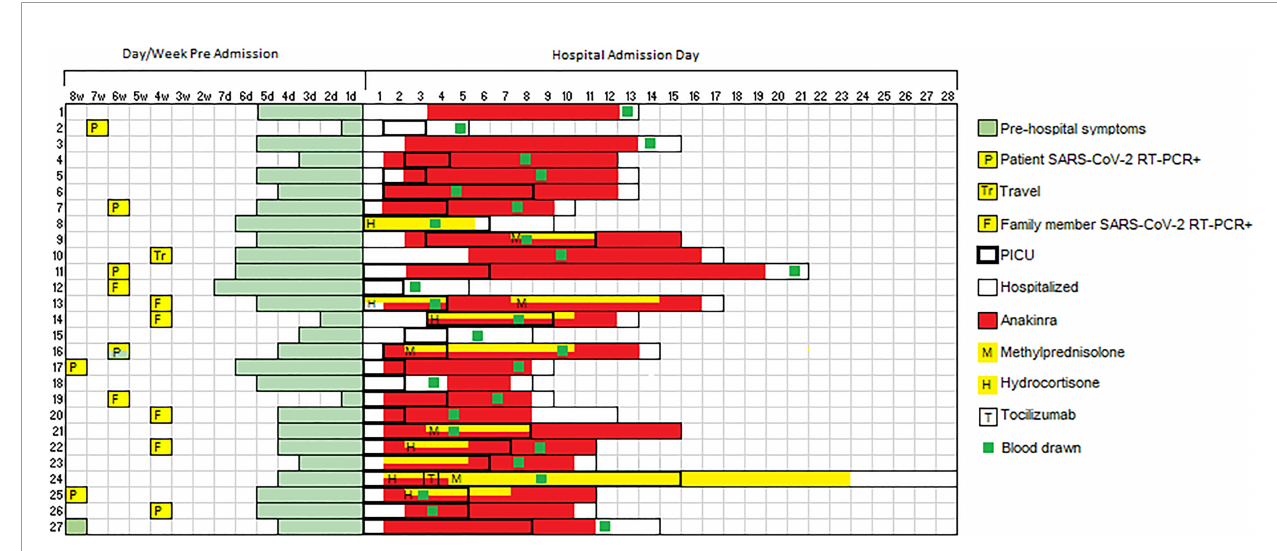
FIGURE 1 | SARS-CoV-2 exposure and MIS-C treatment relative to sample collection. Swimmer plot charting timing of SARS-CoV-2 exposure, symptoms of MIS-C prior to hospitalization, hospital admission, ICU admission, and MIS-C treatment relative to study blood draw. P, patient SARS-CoV-2 RT-PCR positive; F, family member(s) SARS-CoV-2 RT-PCR positive; Tr, travel; H, hydrocortisone; M, methylprednisolone; T, tocilizumab.